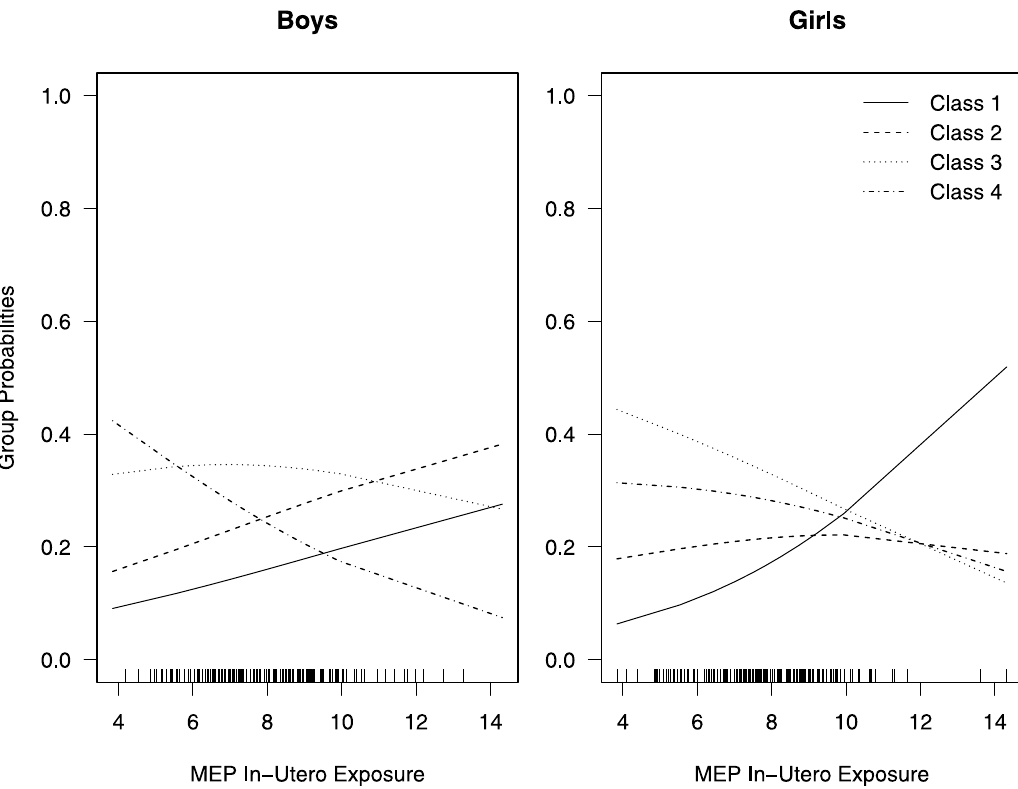
Fig 3. Group probabilities. Estimated group probabilities for maternal MEP exposure for boys and girls from a four-group growth mixture model fit to the CHAMACOS data.